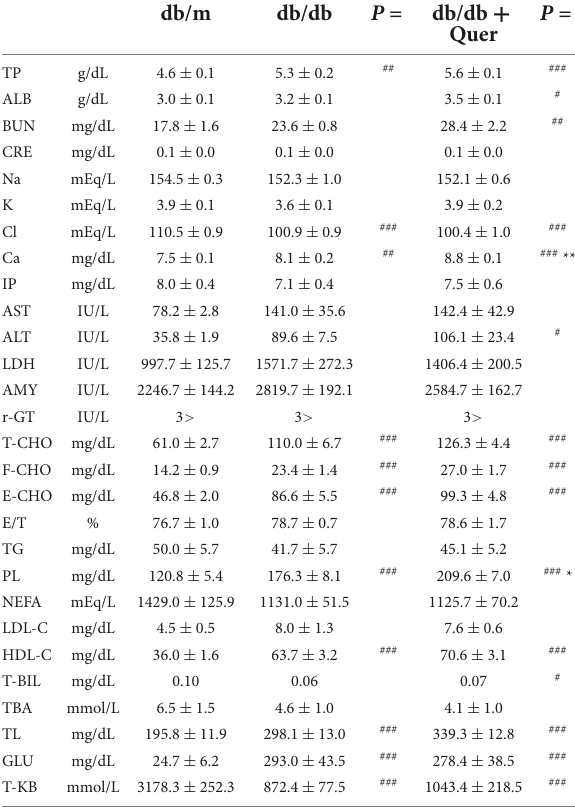
Serum samples were collected from the db/m, the db/db mice and db/db + Quercetin (db/db; Quer) mice (each group, n = 7) at 20 weeks after the start of the experiment. TP, total protein; ALB, albumin; BUN, blood urea nitrogen; CRE, creatinine; Na, sodium;K,potassium;C,chloride;Ca,calcium;IP,inorganicphosphorus;AST,aspartate aminotransferase; ALT, alanine aminotransferase; LDH, lactate dehydrogenase; AMY, amylase; r-GT, gamma-glutamyl transpeptidase; T-CHO, total cholesterol; F-CHO, free cholesterol; E-CHO, cholesteryl esters; E/T, E-CHO/T-CHO; TG, triglycerides; PL, phospholipid; NEFA, non-esterified fatty acid; LDL-C, low-density lipoprotein cholesterol; HDL-C, high-density lipoprotein cholesterol; T-BIL, total bilirubin; TBA, total bile acid; TL, total lipid; T-KB, glucose (GLU) and Total ketone body. Each value represents the mean ± SEM. Statistical significance was calculated by Bonferroni’s correction, ** p < 0.01, * p < 0.05 vs. db/db group. ### p < 0.001, ## p < 0.01, # p <